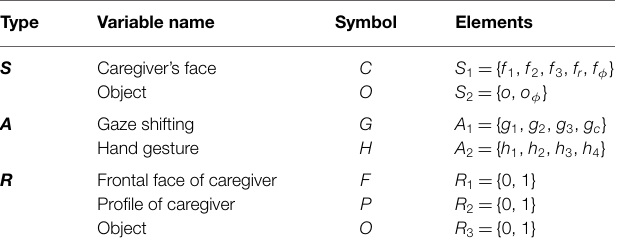
TABLE 1 | Variable setup for the experiment